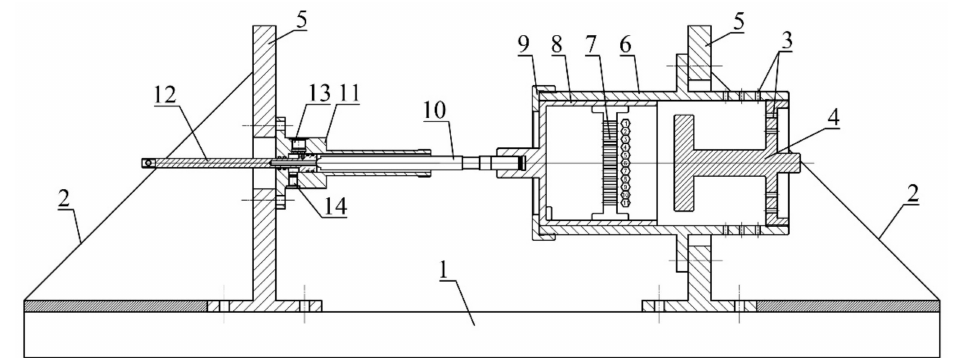
Figure 6. Cross-sectional view of the aluminum honeycomb type of measuring device. 1—base, 2—rib plates, 3—vent port, 4—right end cap, 5—bracket, 6—cylinder, 7—partition plate, 8—compressing plate, 9—left end cap, 10—compression adjustment lever, 11—shell body of pin puller, 12—pin-rod, 13—cartridge port, 14—pressure transducer